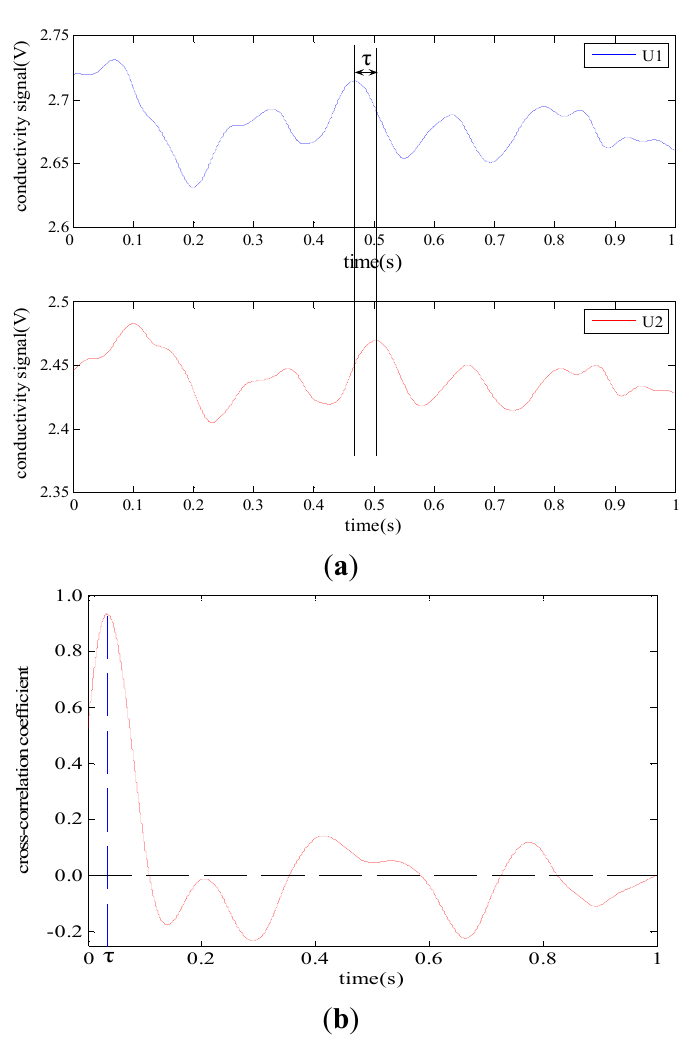
Figure 7. An example of the flow rate measurement. ( a ) Conductivity signals; ( b ) Cross-correlation coefficient